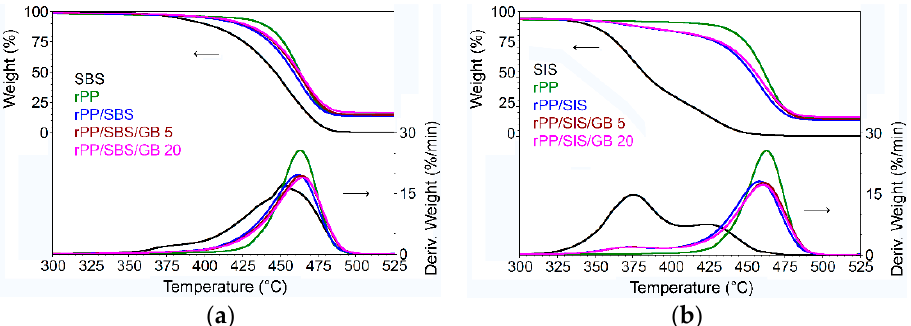
Figure 6. Thermogravimetric analysis (TGA) curves for: ( a ) post-consumer rPP / SBS and post-consumer rPP / SBS / GB composites compared with post-consumer rPP and SBS; ( b ) post-consumer rPP / SIS and post-consumer rPP / SIS / GB composites compared with post-consumer rPP and SIS.